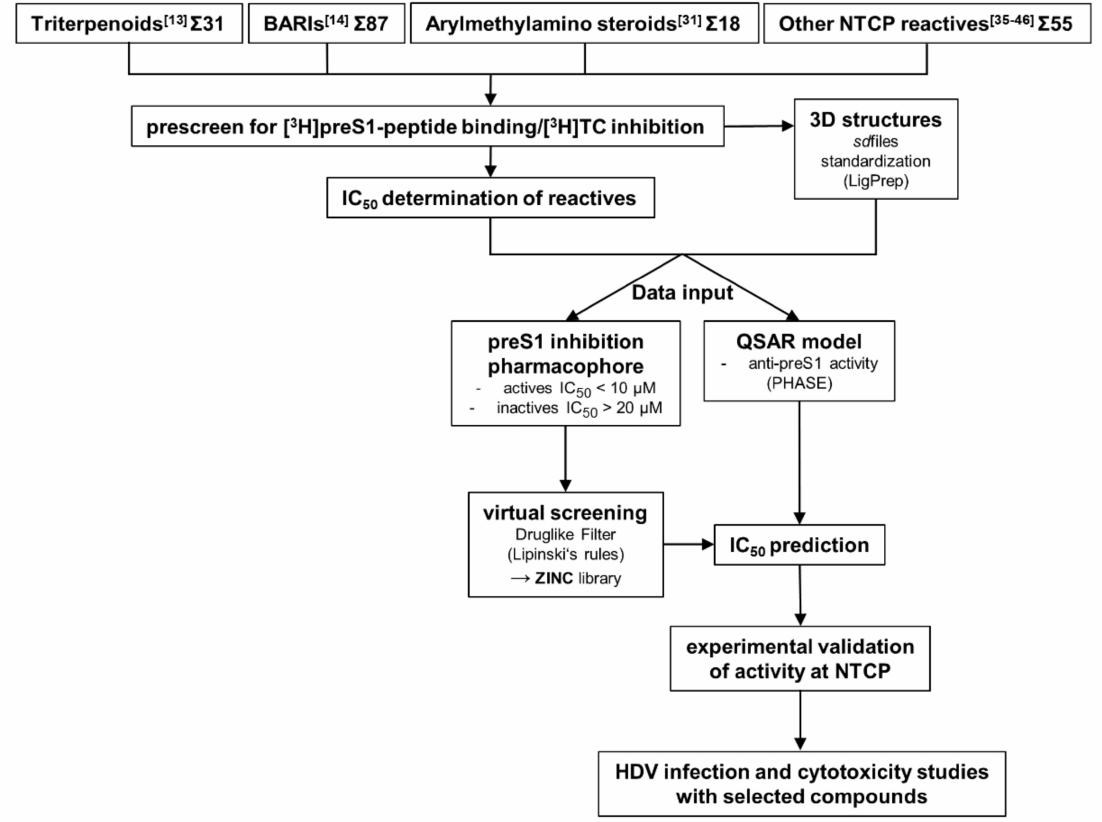
Figure 1. Workflow of the study. The study started with four different compound groups. Three of them were identified as NTCP inhibitors before (see references [13,14,35–46]). Arylmethylamino steroids were shown to have antiparasitic activity (see reference [31]) and were established as novel NTCP inhibitors for the first time in the present study. BARIs = bile acid reabsorption inhibitors; QSAR = quantitative structure-activity relationship.